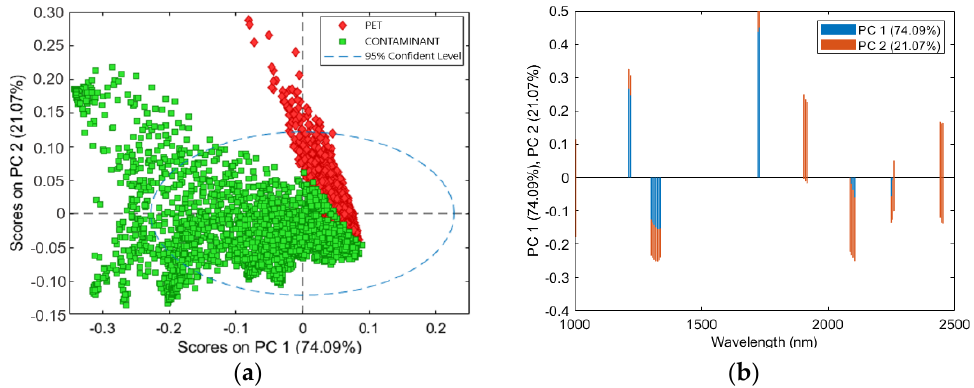
Figure 5. PCA results for the preprocessing Set 1 (Detrend + Smoothing + MC): PCA score plot (PC1-PC2) ( a ) and loadings plot of PC1 and PC2 related to PET and contaminant classes ( b ).